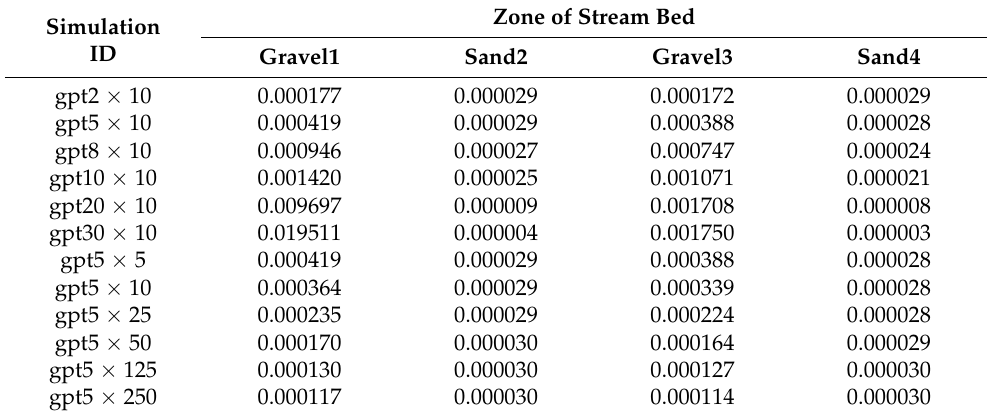
Table 4. Variation in HHG in the transition zones of gravel and sand portion of the